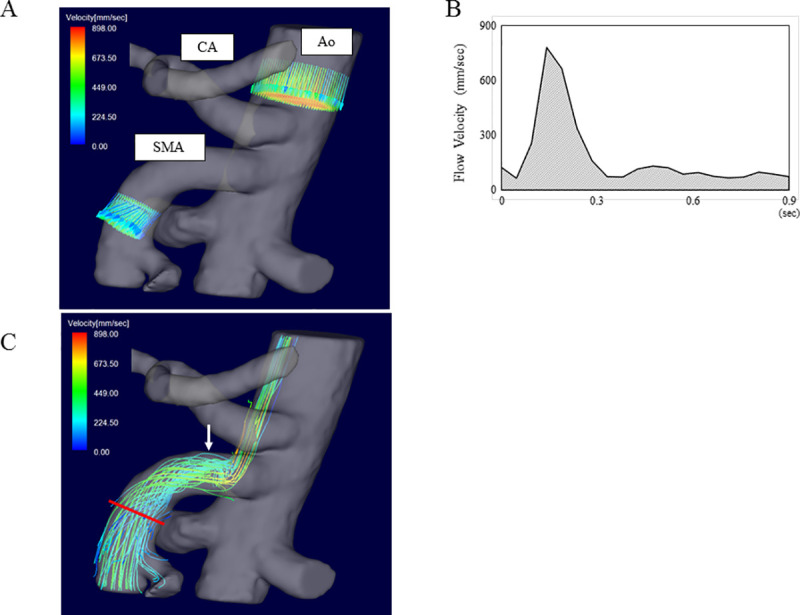
Measurement of SMA blood flow by 4D PC-VIPR.(A) Abdominal blood vessels depicted by 4D PC-VIPR. Three-dimensional velocity data derived from 4D PC-VIPR was incorporated with the MRA morphology in a 3D vector field fashion. Flow velocity and FV can be measured at any location analyzed by using dedicated software. (B) Graph of the values obtained from the data. The shaded area indicates FV. (C) Flow velocity can be measured in all locations of the SMA by adding the blood flow velocity and direction as vector data using dedicated software. Disturbed non-laminar (i.e., vortex and/or helical) flow (arrow) can be shown by streamline analysis. The measurement was performed while avoiding the area of non-laminar flow.